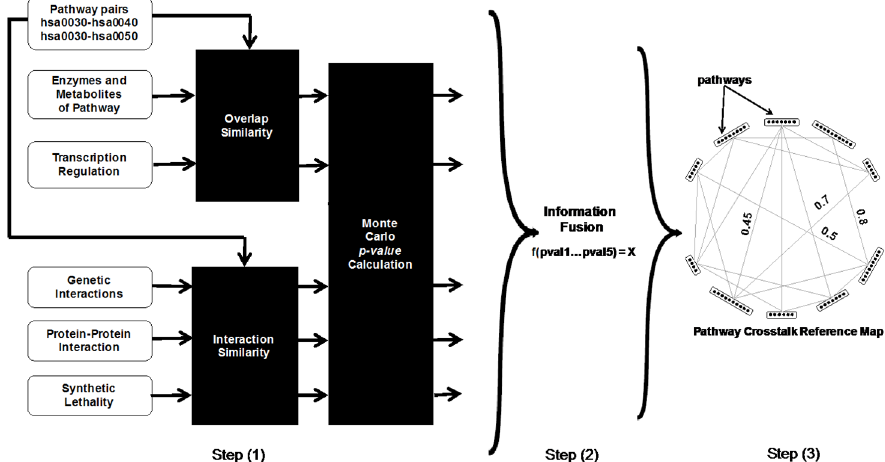
Figure 1. Identification of potential pathway crosstalks. The methodology has three steps: ( 1 ) quantifying crosstalk likelihood using multiple individual evidence to score each pathway pair, ( 2 ) obtaining a combined score using information fusion, and ( 3 ) building the crosstalk reference map.